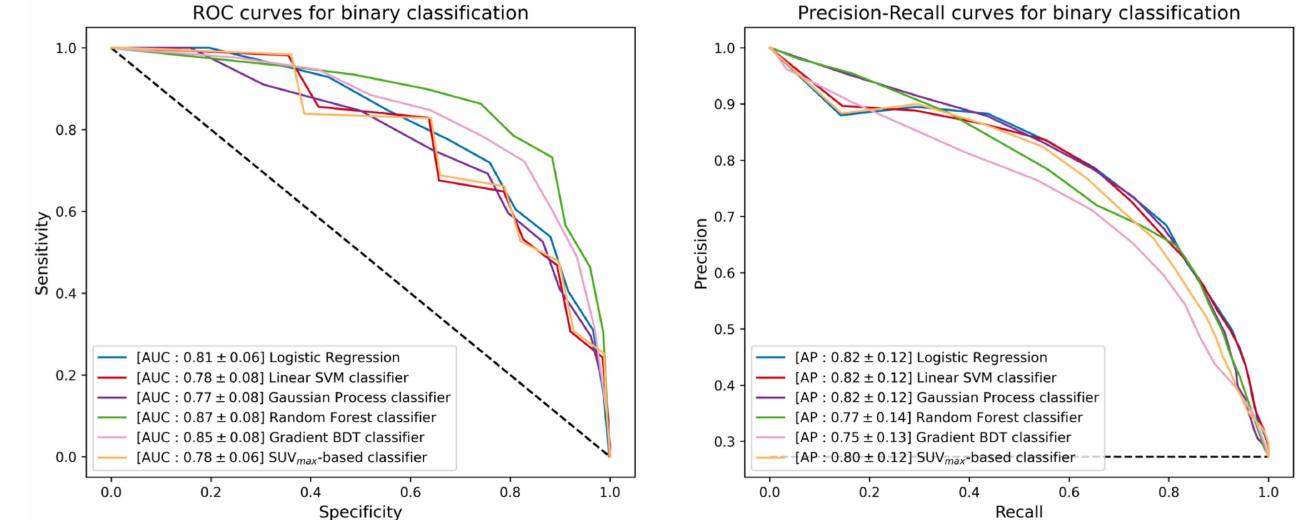
Figure 5. ROC curves ( left ) and precision-recall curves ( right ) of the different binary classifiers under investigation. Each classifier is reported together with mean and standard deviation (in square brackets) of the AUC and AP scores achieved during a 300-iterated bootstrap